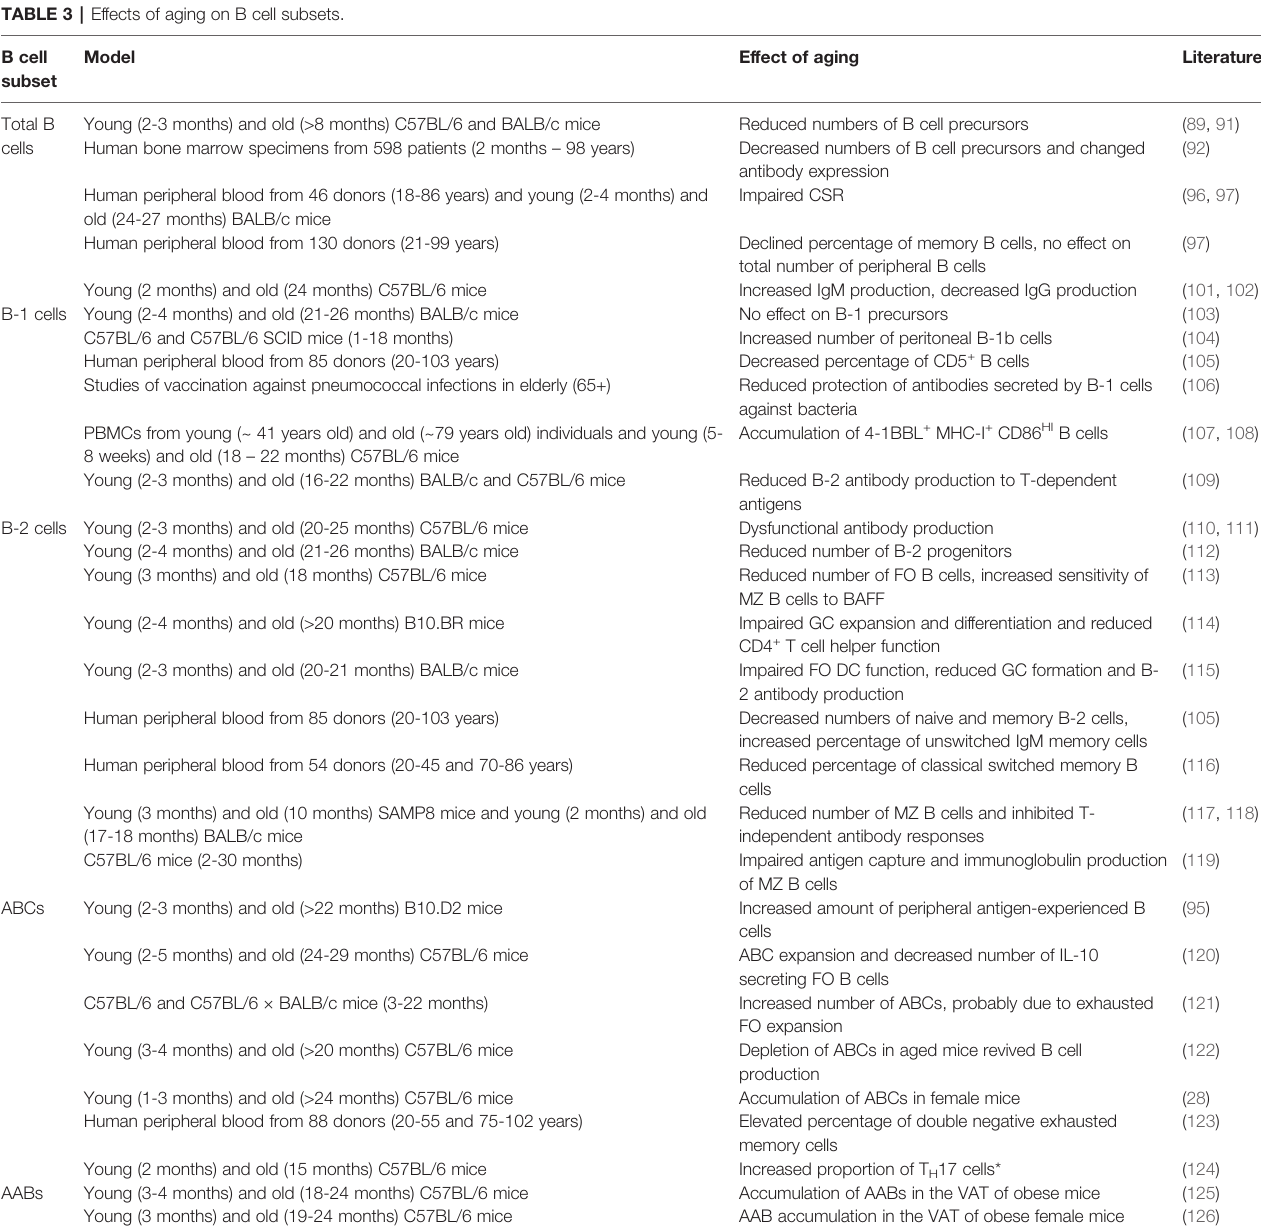
TABLE 3 | Effects of aging on B cell